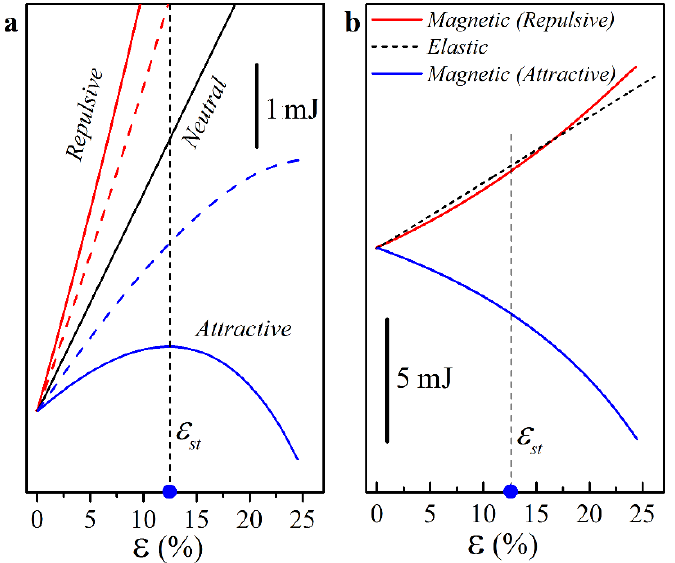
Figure 4. Numerically obtained dependencies of the energy of the unit cell on the applied strain ε . ( a ) Total energy vs. ε for various configurations of magnets. Solid lines correspond to the magnets with m = 0.105 Am 2 , dashed lines to the magnets with m = 0.075 Am 2 . ( b ) Magnetic energy for repulsive configuration (red), attractive configuration (blue), and elastic energy for neutral configuration (dashed). Note that all energy curves are shifted vertically to have a (0, 0) origin.